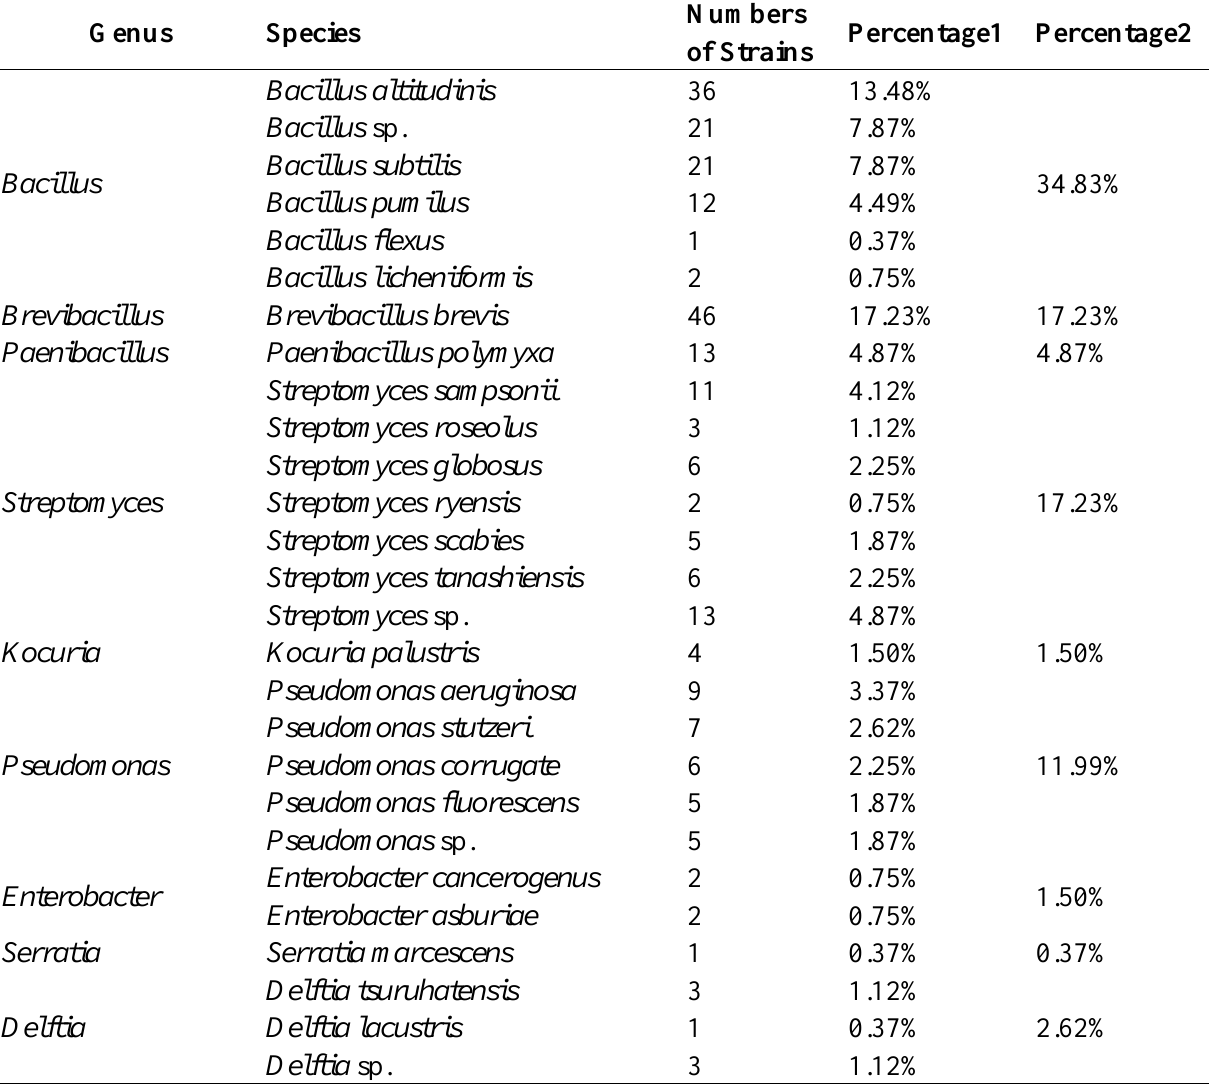
Table 2. List of the species richness of antagonistic bacteria obtained in this